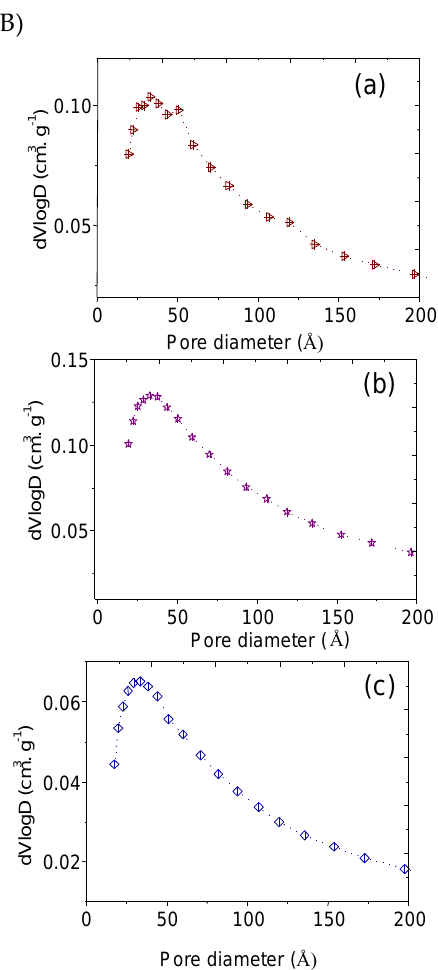
Figure 3. ( A ) Nitrogen physisorption isotherms and ( B ) their corresponding the pore size distribution curves of the catalysts: ( a ) CoMo / Nb 2 O 5 , ( b ) PtMo / Nb 2 O 5 , and ( c ) NiMo / Nb 2 O 5